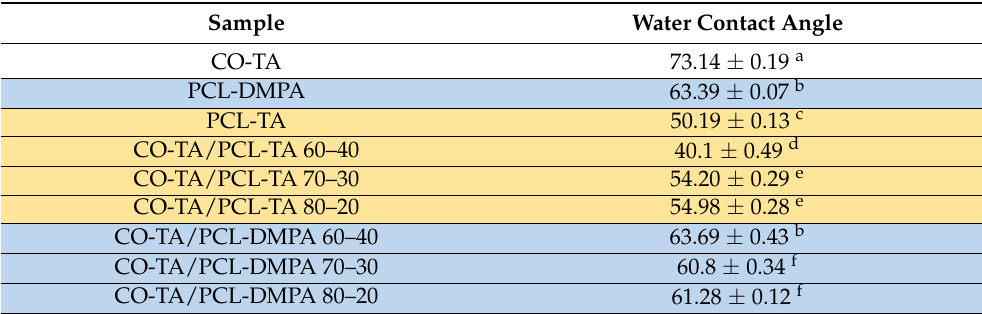
Table 2. Water contact angle measured on the films’ surfaces. Different letters correspond to samples that show statistically significant